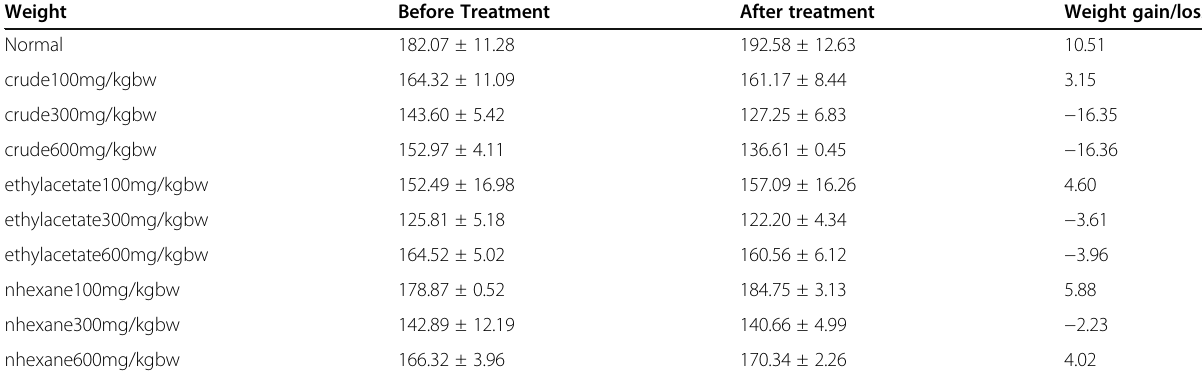
Table 4 Effect of crude extract and fractions of Gymnema sylvestre on bodyweight gain of albino rats Weight Before Treatment After treatment Weight